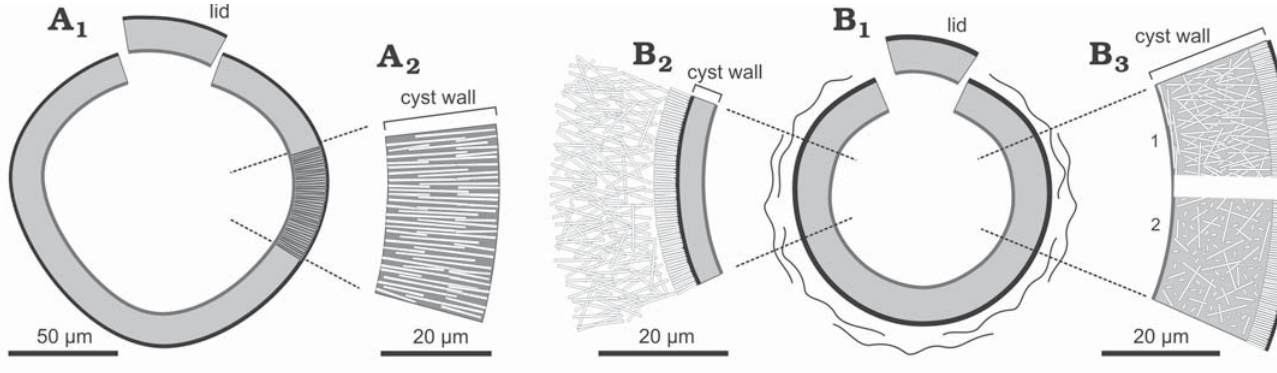
Fig. 10. Scheme of gametangium and mineralization of Acetabularia moldavica sp. nov. (A) and extant polyphysaceans (B). A . Gametangium in axial section (A 1 ), stratified wall (gray), and mineralization (sector); detail of the cyst wall with acicular crystals of aragonite (A 2 ). B . Extant polyphysaceans (B 1 ), cyst wall and detached lid (gray), intergametangial space (wavy lines), not to scale. Acetabularia schenckii (B 2 ), arrangement of aragonite crystals (data from Bailey et al. 1976). Chalmasia antillana from Florida Bay (1, Blackwater Sound; 2, Rodrigues Key) (B 3 ), arrangement of aragonite crystals (data from Bailey et al. 1976; Marszalek